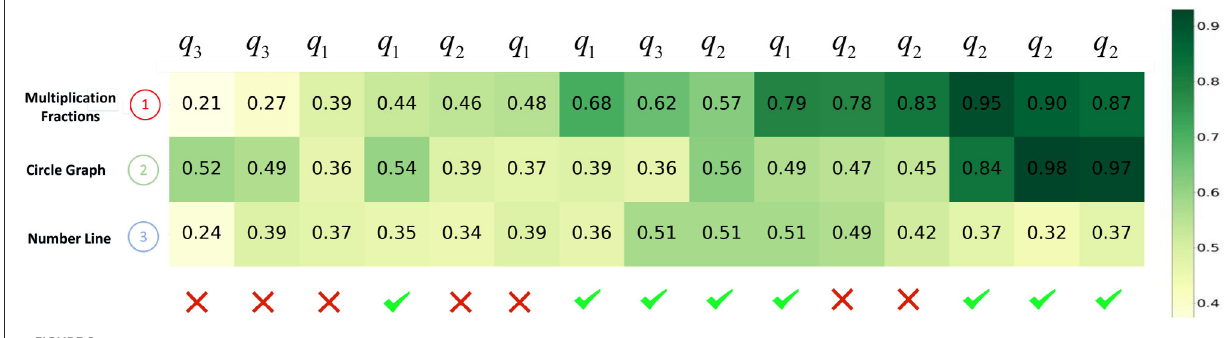
FIGURE8 The evolution of predicted knowledge states produced by CECAKT. The y-axis represents the knowledge concepts, and the x-axis represents the student’s responses to a sequence of the questions. The grids represent the predicted knowledge states, i.e., the predicted probabilities that the student has mastered the knowledge concepts.